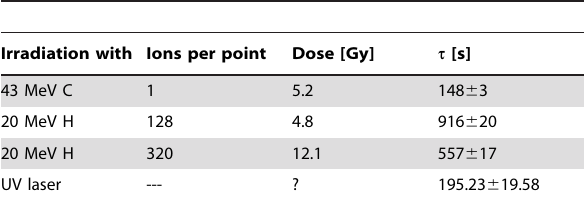
Rad52 kinetics after carbon and proton irradiation of cell pool U2OS pEGFP- Rad52. Indicated are the times after irradiation until foci formation is visible by eye in microscopic images.